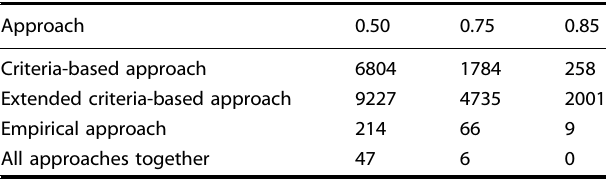
Table 2. Number of predicted suitable materials vs. ML model con fi